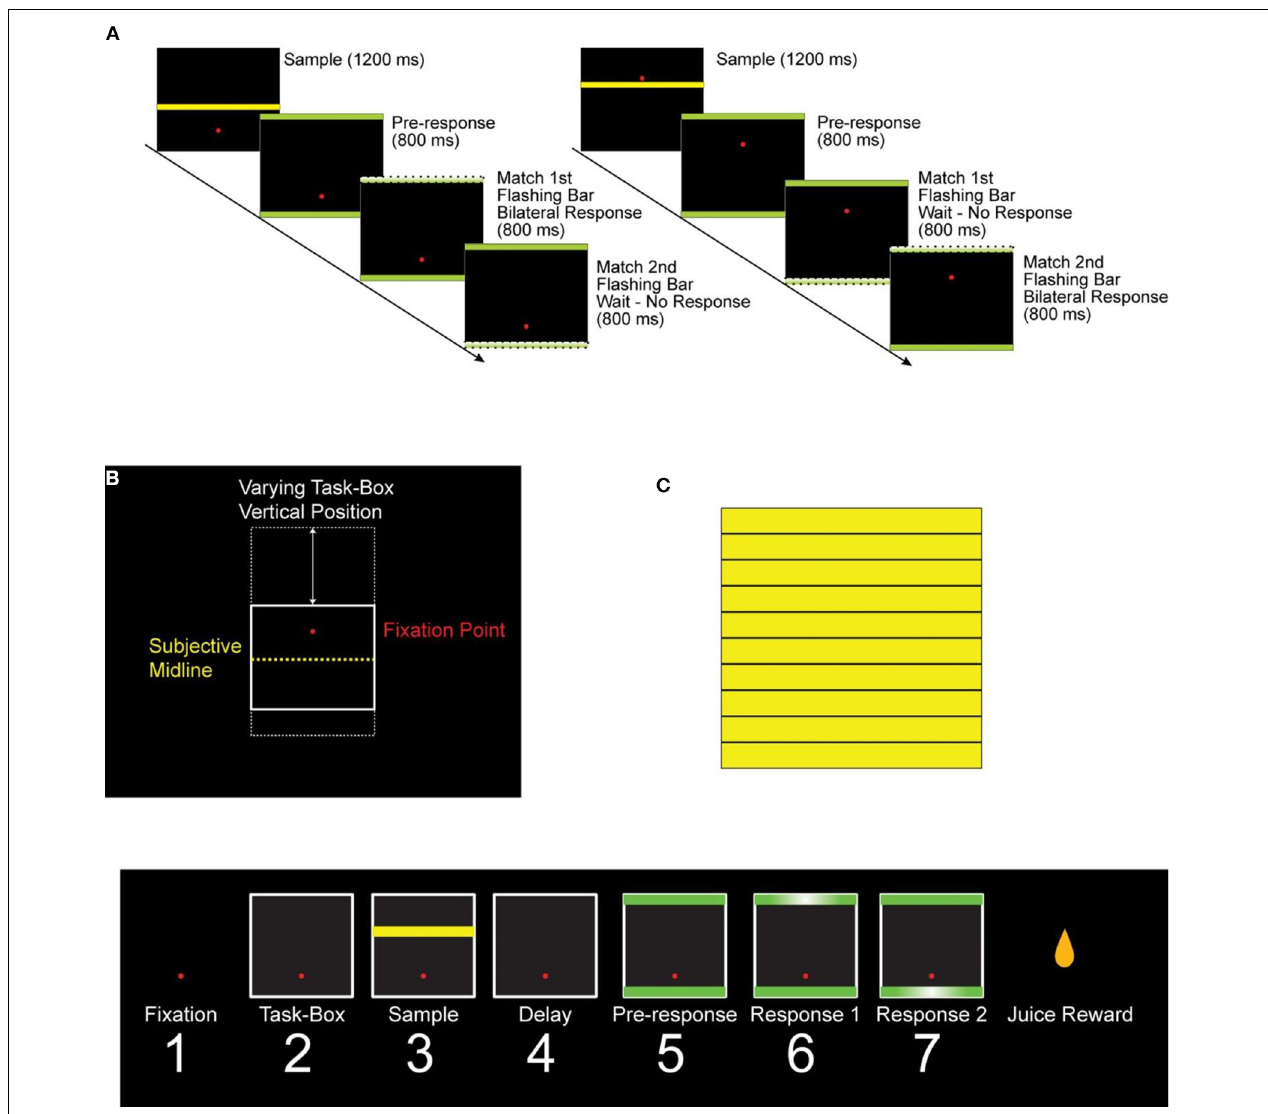
FIGURE 1 | “High/Low” delayed matched-to-sample space categorization task. (A) Sample trials of the task. After the monkey fixated the red dot, a black task box appeared on a screen in front of the monkey. The vertical position of the box within the screen varied randomly in different trials (B) . Following a brief delay, a yellow sample bar was displayed for 1.2s. Following another brief delay (0.5s), two green response bars appeared simultaneously on the top and bottom of the task box. After a delay (1.5s for monkey 1 and 0.8s for monkey 2), the response bars would flash for 0.8s in